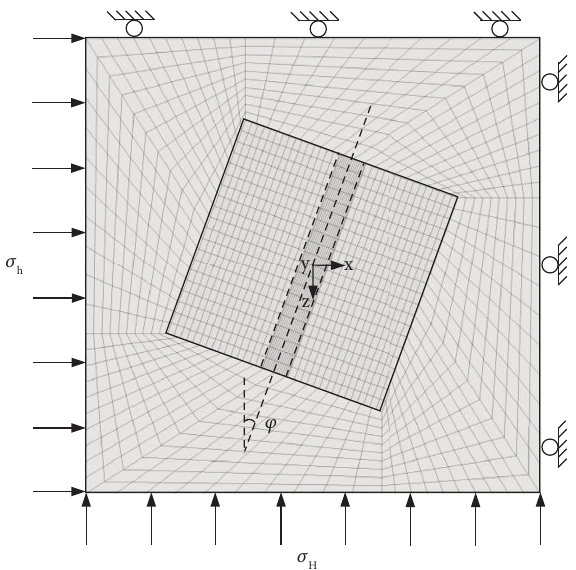
Figure 5: x - z section view of the meshed model with specific boundaries and loading conditions ( φ � 20 °